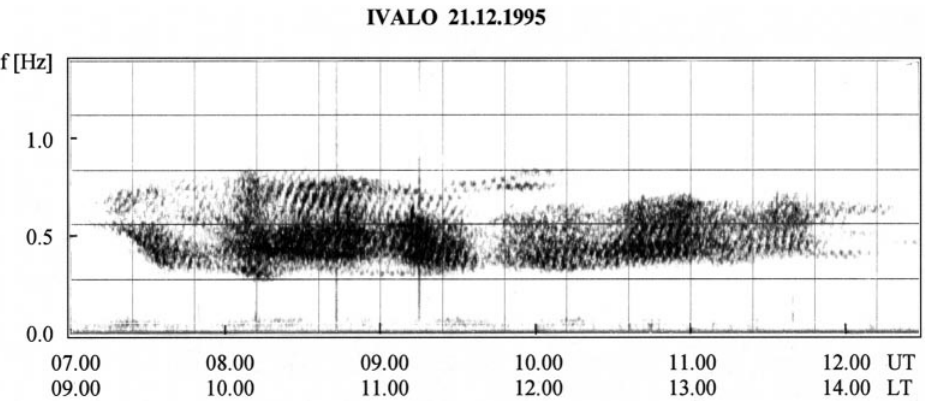
Fig. 7. The sonagram of Pc1 pulsations observed at Ivalo on December 21, 1995, depicting a quasi-stationarycentralfrequency and